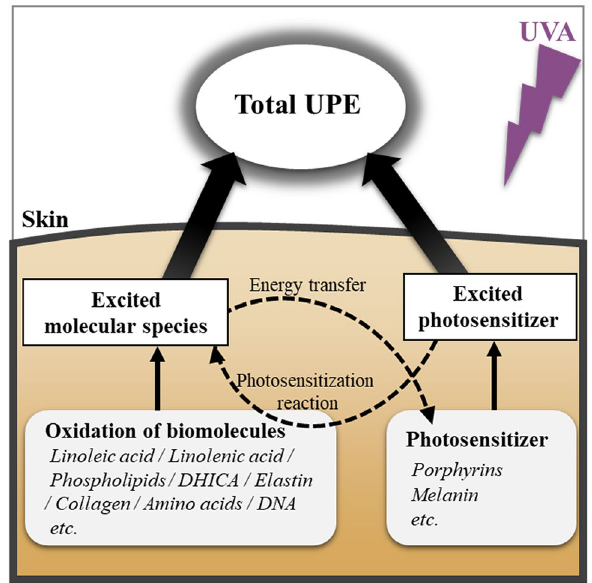
Figure 3. Scheme of the proposed mechanism of UPE generation in the skin by UVA irradiation. UVA irradiation causes UPE generation through oxidation of biomolecules in the skin via several pathways. Biomolecules exposed to UV directly generate UPE, while photosensitizers in the skin are excited by UV exposure. The excited photosensitizers oxidize biomolecules, and UPE is generated via the photosensitization reaction. The excited photosensitizer itself can act as a UPE source too. The UPE measured by the spectroscopy system, therefore, must have comprised the UPE from each of these pathways with a broad spectral pattern that peaked at 530–580